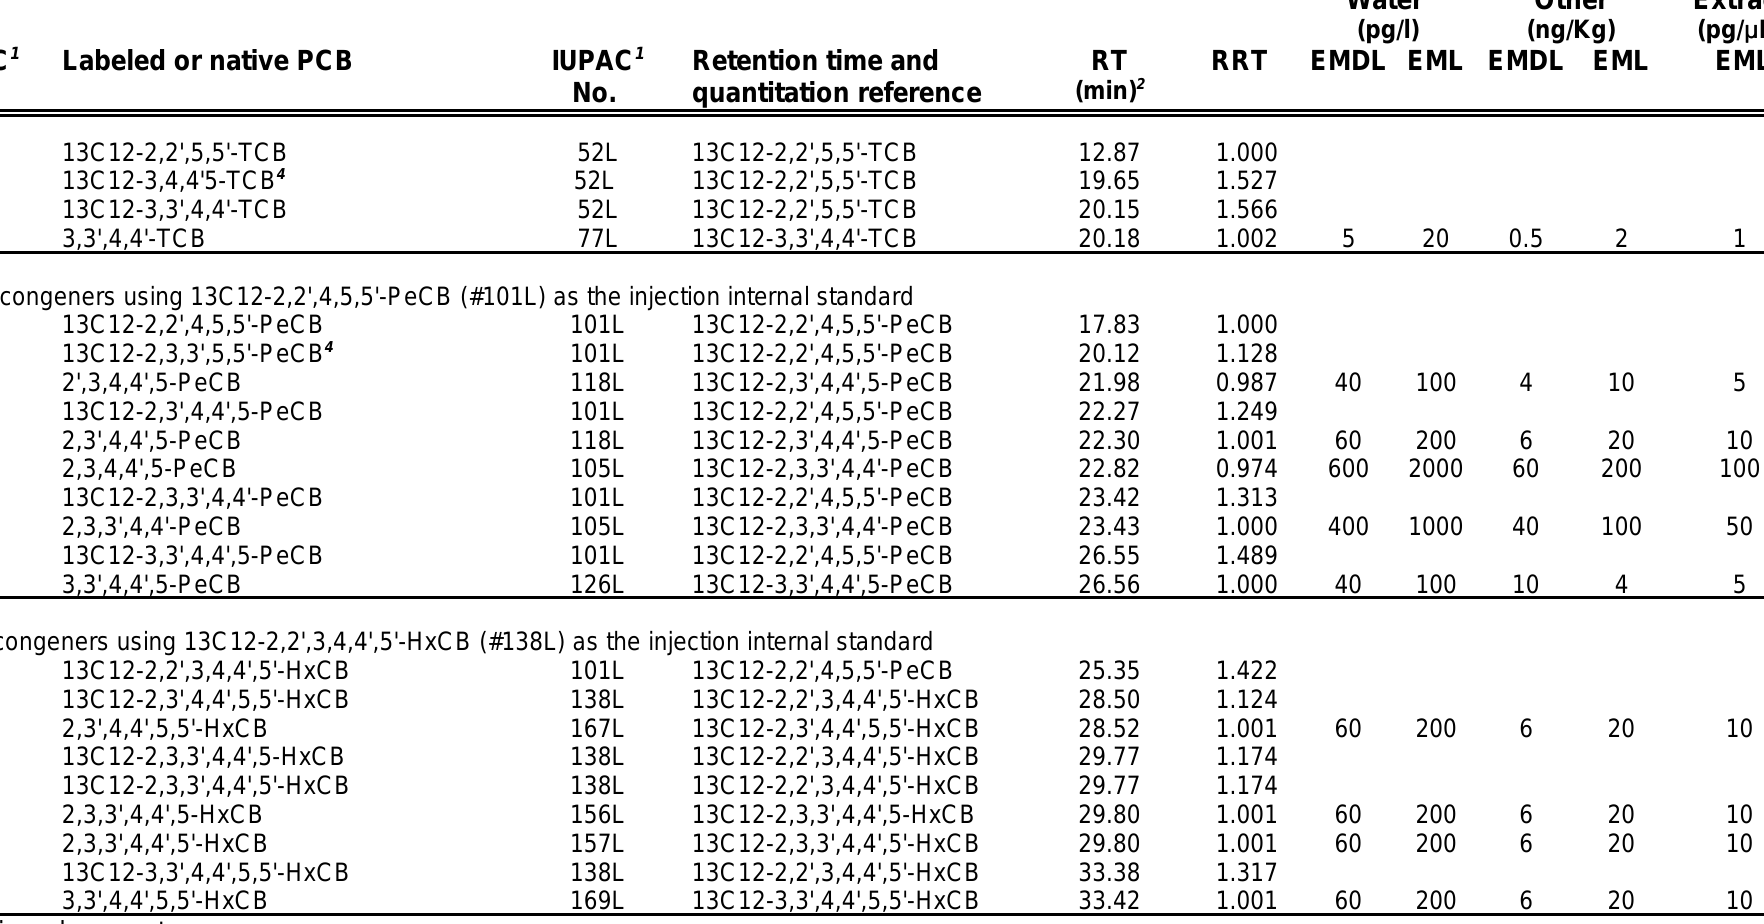
Matrix and Concentration Water Other Extract (pg/l) (ng/Kg) (pg/ ::